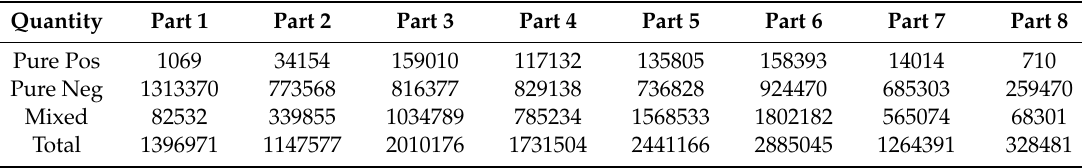
Table 2. The number of samples in each geographically partitioned